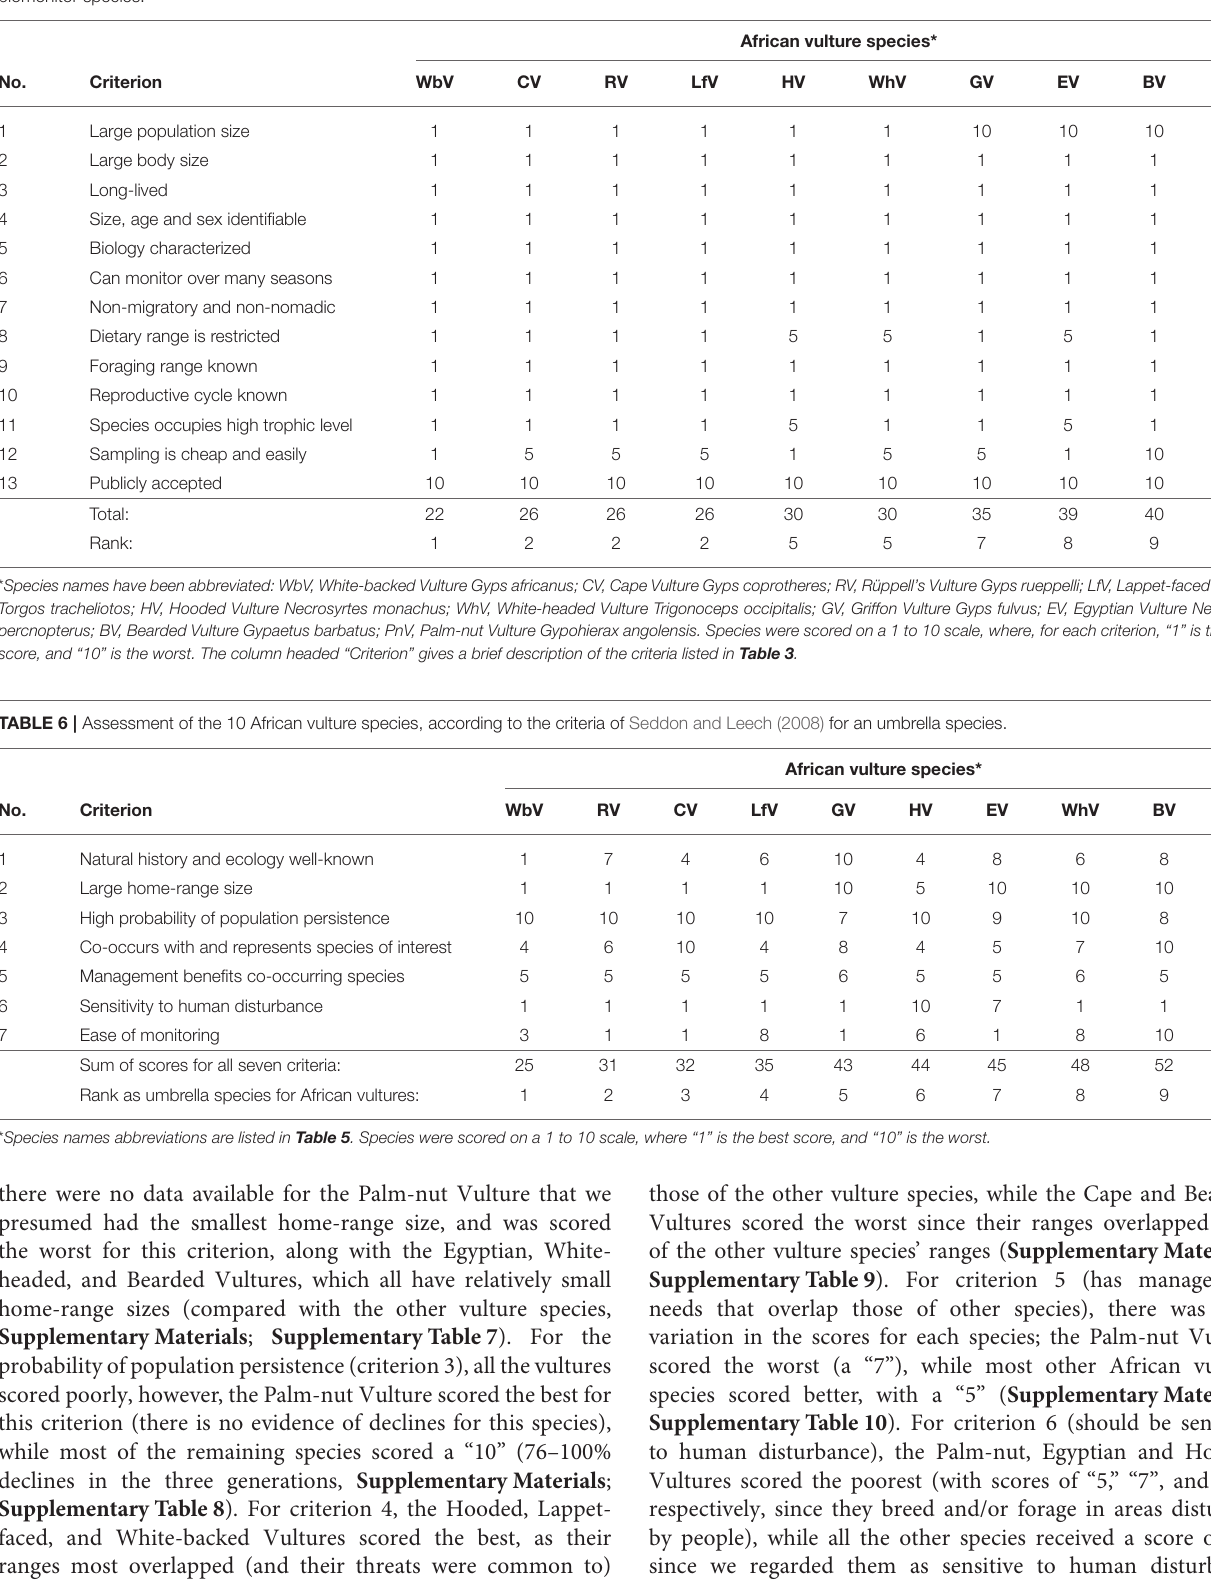
TABLE 5 | The 10 African vulture species, scored according to the assessment criteria that Hollamby et al. (2006) considered to be important when selecting an avian biomonitor species. No.